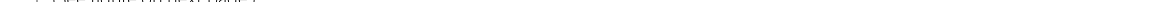
figure on next Fig. 3 A comparison of growth patterns and salinity stress responses among OsERF106MZ ‑overexpressing transformants (OE1 and OE2), the Oserf106mz mutant, and the corresponding WT cultivars under normal (0 mM NaCl) and NaCl‑treated (150 mM NaCl) conditions. a Quantification of OsERF106MZ mRNA levels in OsERF106MZ ‑overexpressing transformants, the Oserf106mz mutant, and the corresponding WT cultivars by qPCR. The positions of the primers are indicated by purple arrows in Additional file 1: Figure S9A. The primer sequences are listed in Additional file 2: Table S1. The seedlings were grown on basal medium for 11 days and then subjected to qPCR assays. b Morphological appearance of the OsERF106MZ ‑overexpressing transformants, Oserf106mz mutant, and the corresponding WT cultivars. c The shoot and root lengths of the OsERF106MZ ‑overexpressing transformants, Oserf106mz mutant, and the corresponding WT cultivars. d Morphological phenotype and survival rate of the OsERF106MZ ‑overexpressing transformants and its corresponding WT cultivars. The seedlings used for the assessment of morphological characteristics such as shoot and root lengths ( b and c ) and the calculation of survival rates ( d ) were grown on basal medium for 7 days and then transferred to basal medium containing 0 or 150 mM NaCl for an additional 4 and 6 days, respectively. The values of shoot and root lengths ( c ) are the mean SE of at least five biological replicates, each with two technical replicates. All survival rates (d) are the mean ± biological replicates. Each biological replicate contains at least 20 seedlings. Asterisks indicate significant differences (* P < 0.05 and ** P < 0.01) in comparison to the corresponding WT based on Student’s t